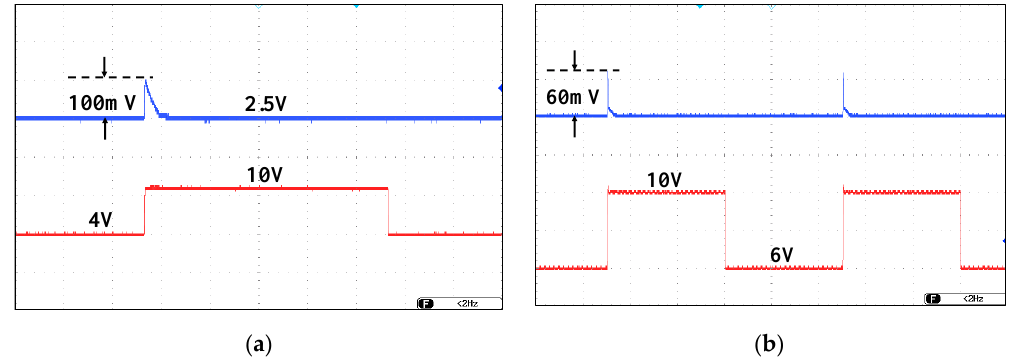
Figure 12. Measured transient line performance of the proposed linear regulator. ( a ) load current is 10 mA; ( b ) load current is 50 mA.